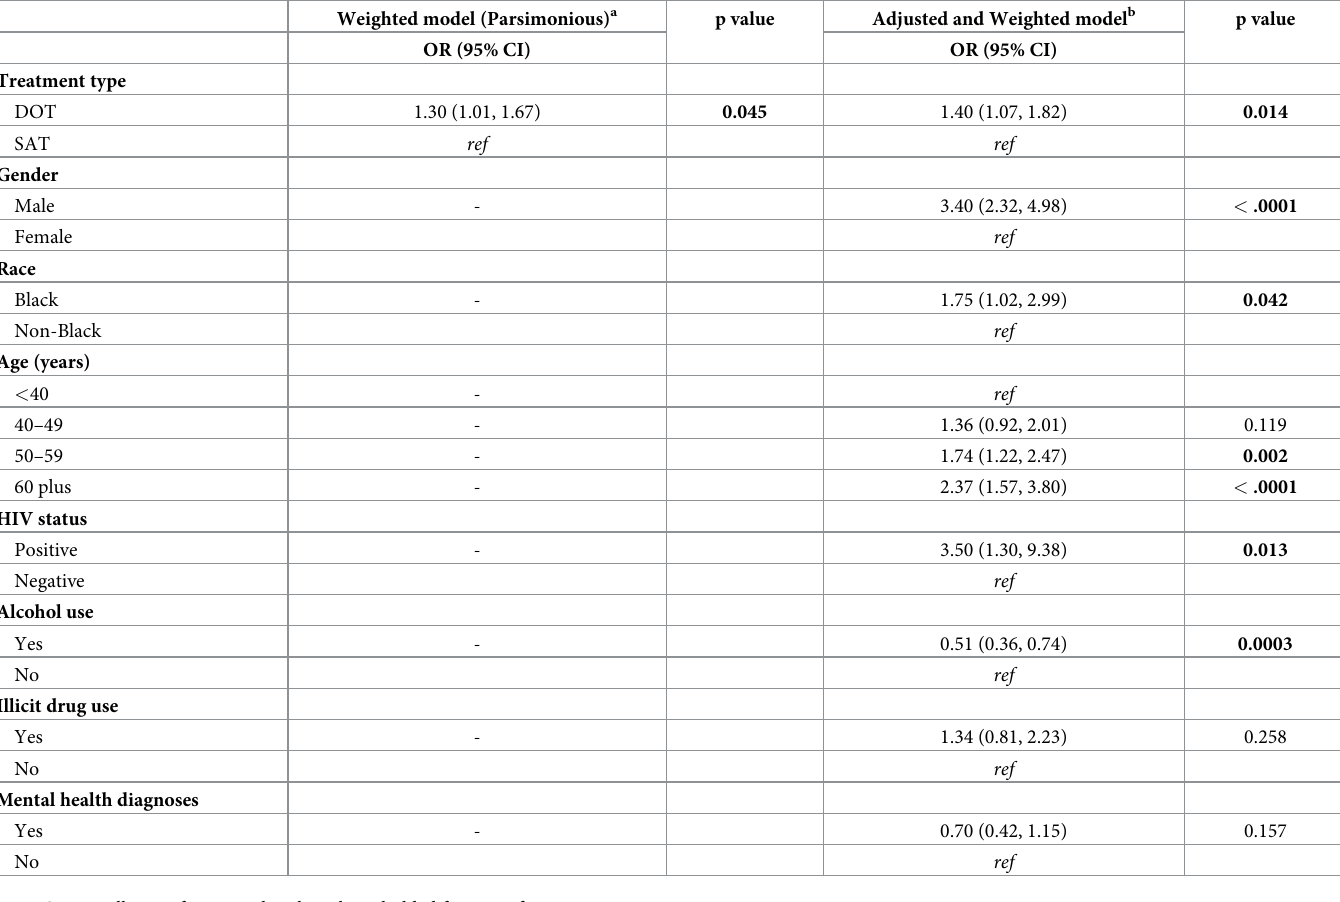
Table 5. Adjusted odds ratios of LTBI treatment completion among 274 homeless adults treated with 4 months of daily rifampin in Fulton County, Georgia (2014–